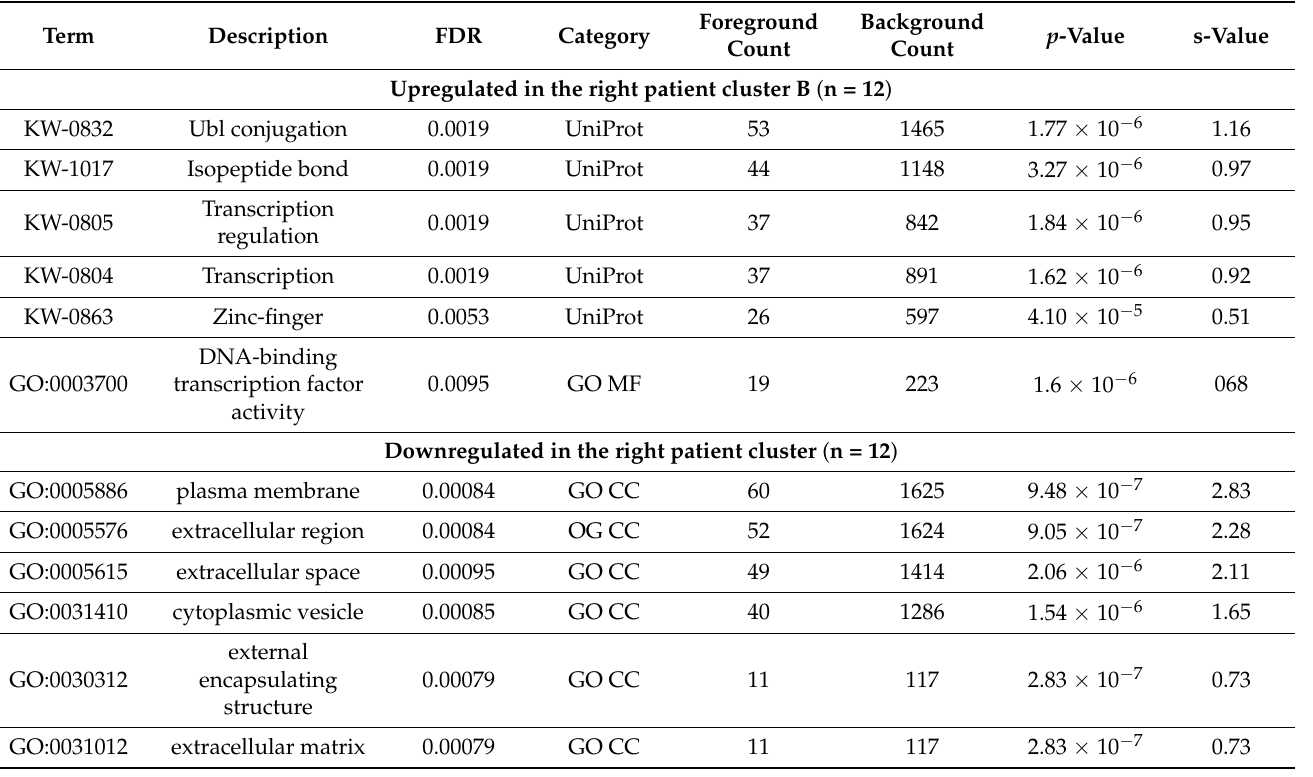
Table 4. Classification of proteins showing differential expression when comparing AML cells from the two main patient clusters identified in the hierarchical clustering analysis (Figure 3). The analysis is based on the overall proteomic profiles for the 32 patients. The table presents the six terms with the lowest false discovery rate (FDR) when analyzing GO cellular component/cellular component text mining, GO biological process, GO cell components, GO molecular function, KEGG pathways, Reactome pathways, and UniProt keywords. The table presents the description of each term together with foreground and background counts, p - and s-values. S-value is a combination of (minus log) p value and effect size (i.e., positive associations in the foreground divided by all associations); a positive value indicates overrepresentation of a given term, and a negative value indicates underrepresentation of a given term. Foreground counts indicate the number of positive associations in a given cluster for a given term (i.e., the number of proteins associated with the given term) and background counts indicate the number of positive associations in the dataset.